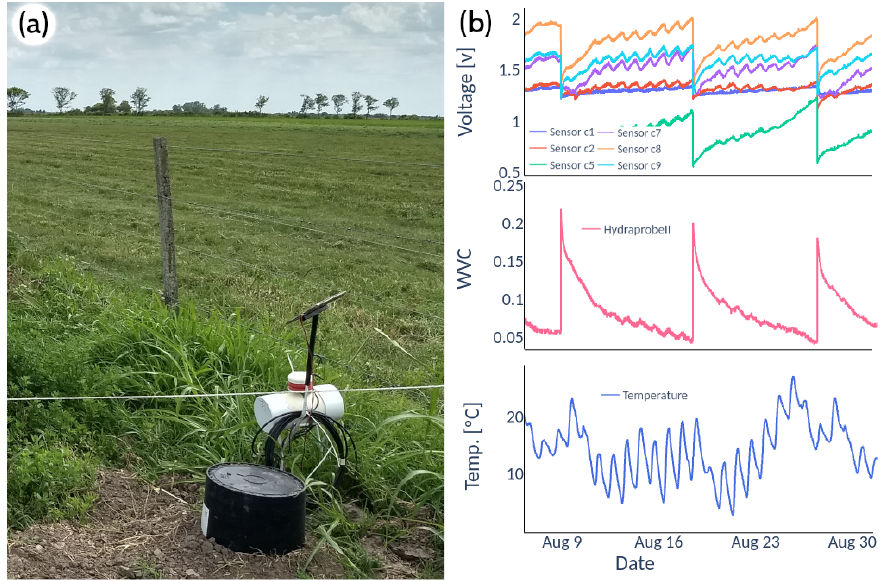
Figure 8. ( a ) Acquisition of real-time data in field conditions; ( b ) field data of sensors SKU, Hy- draprobe II and soil